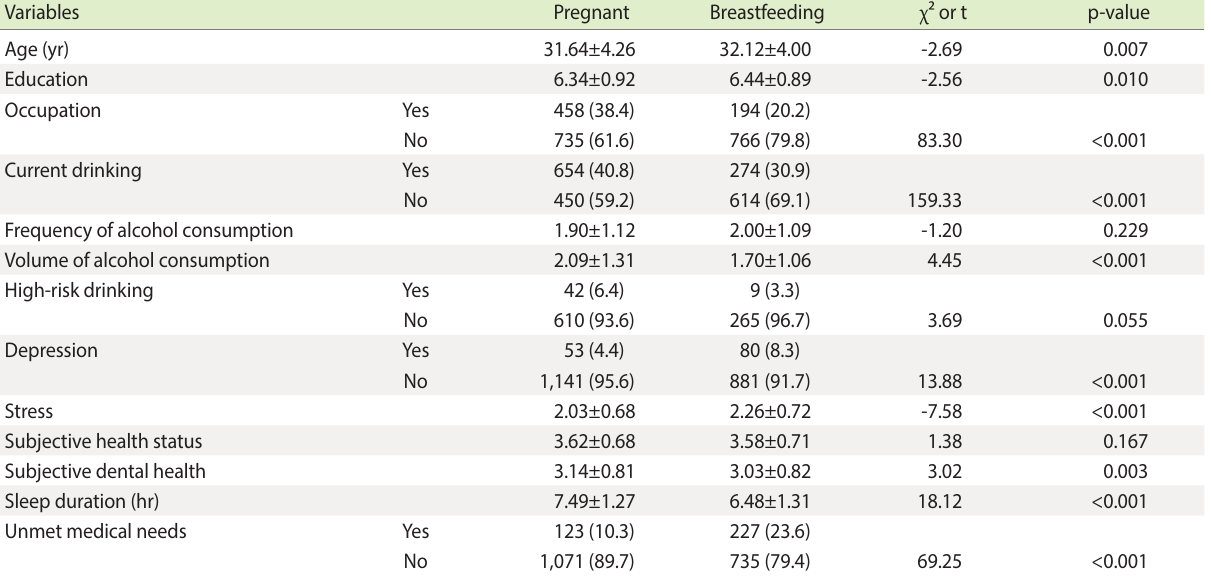
Table 1. Current drinking and health status in relation to pregnancy and breastfeeding (n=2,156) Variables